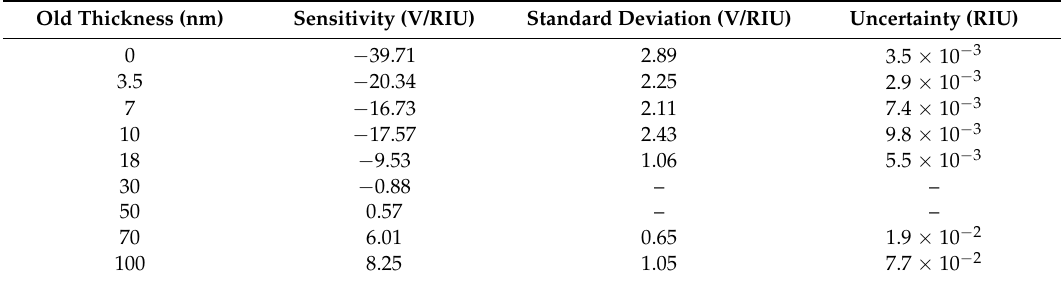
Table 1. Summary of the biosensors average sensitivities, standard deviations and maximum expanded uncertainties (95% confidence level) in Setup